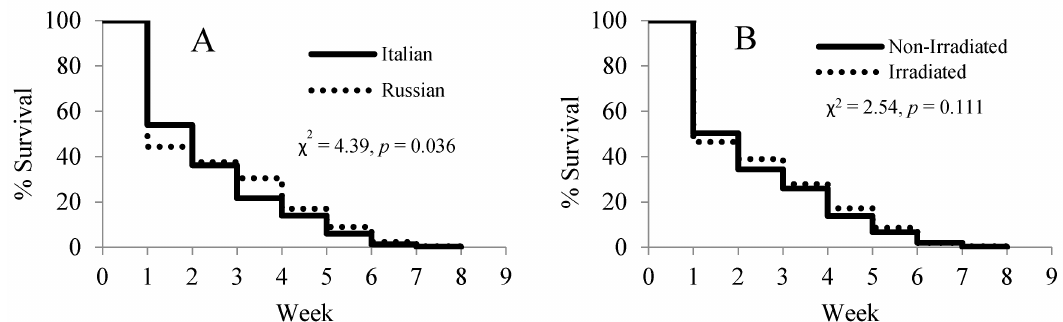
Figure 5. Effects of honey bee stock ( A ) and comb irradiation ( B ) on the survival of paint-marked bees. A total of 1411 Russian and 1292 Italian bees were marked.